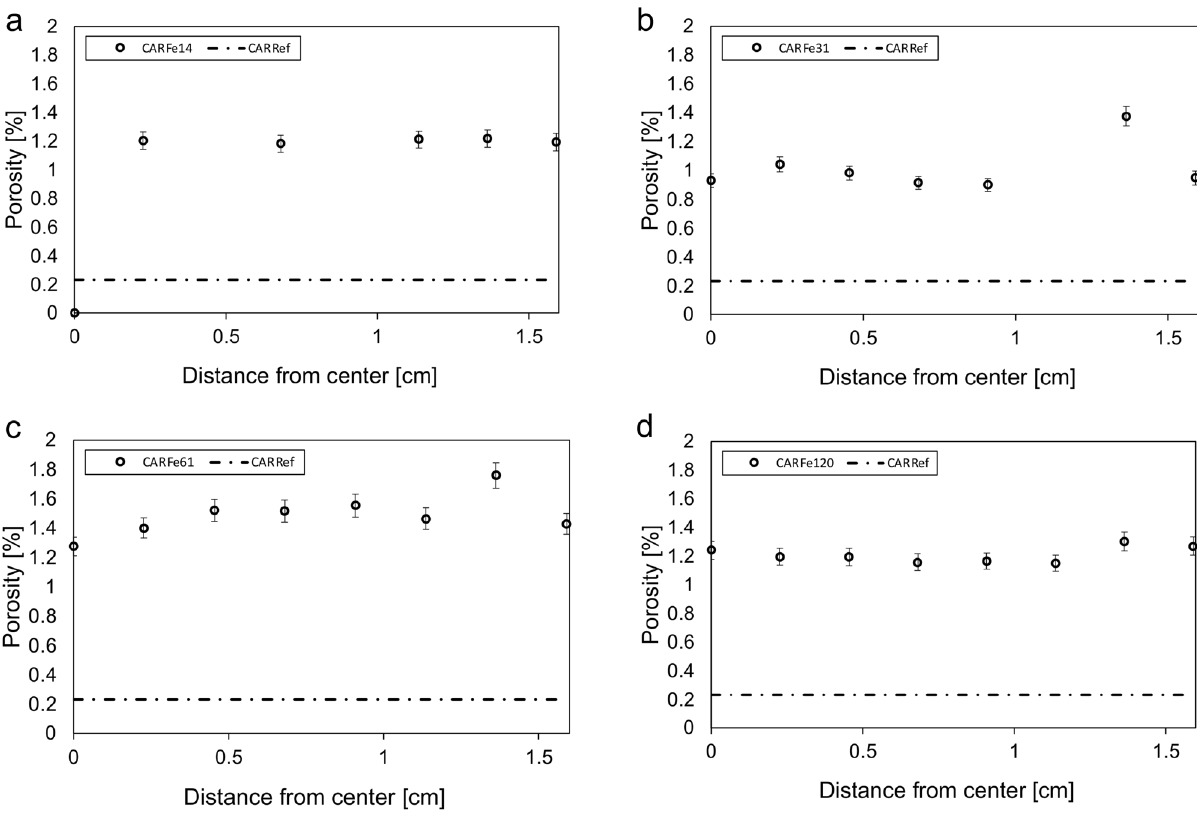
Figure 5. Porosity development in the CAR marble with reaction time as characterized by (U)SAXS. Porosity is elevated in comparison to the pristine sample, but no rim is